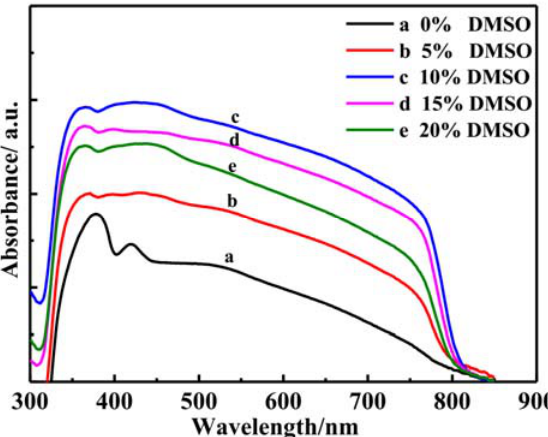
Figure 8. UV-vis absorption spectra of perovskite nanowires film with different ratios of DMSO